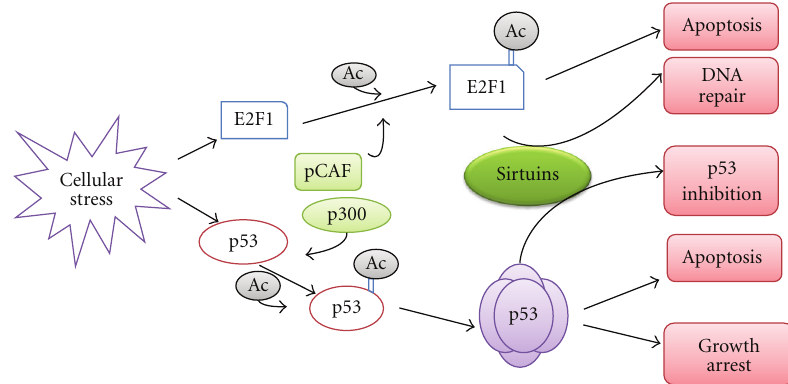
Figure 4: Role of sirtuins in the celluar response to